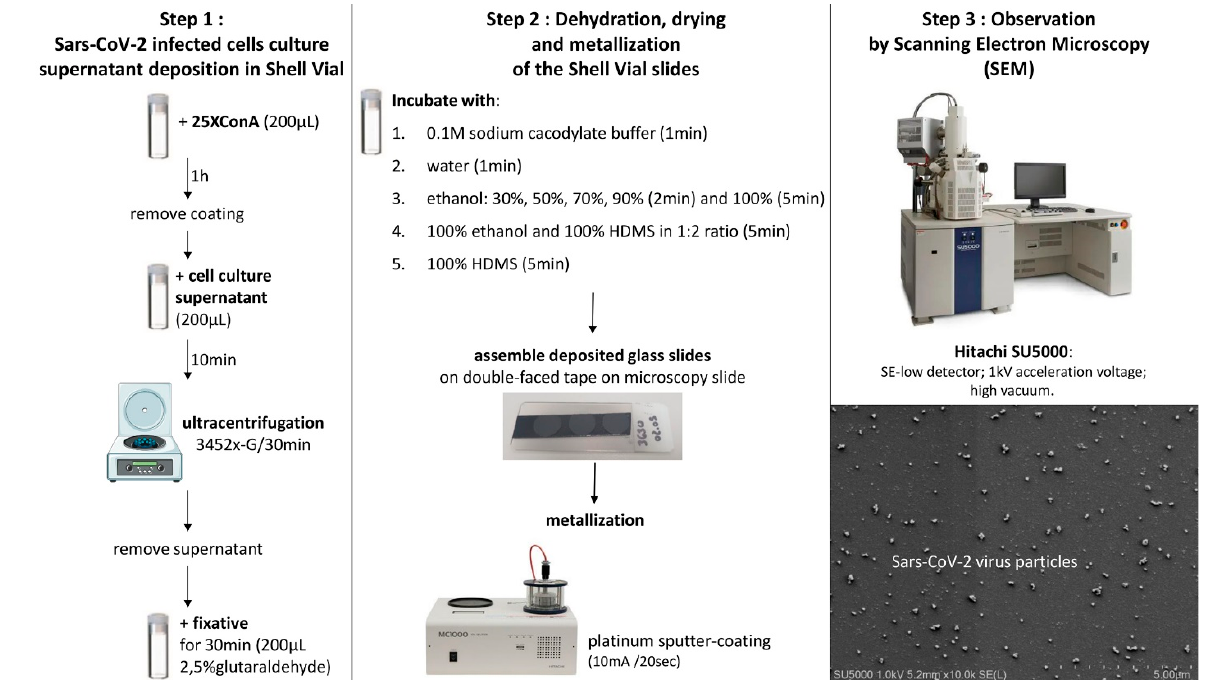
Figure 7. Recapitulative scheme for improved viral diagnosis of SARS-CoV-2-infected cell culture supernatants by scanning electron microscopy.